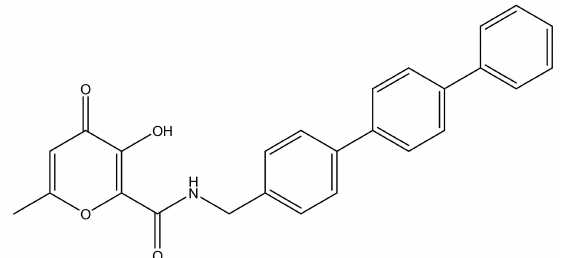
Figure 14. Best hydroxypyrone-based matrix metalloproteinases inhibitor (MMPI) developed by Aerts et al.